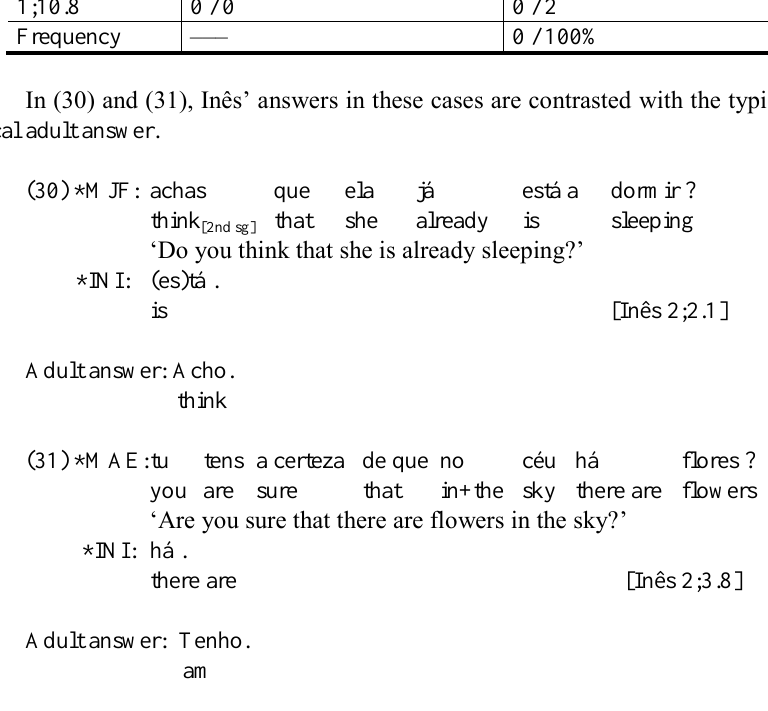
Only the reply involving the higher verb is available Number of answers using the embedded verb / number of answers using the verb in the main